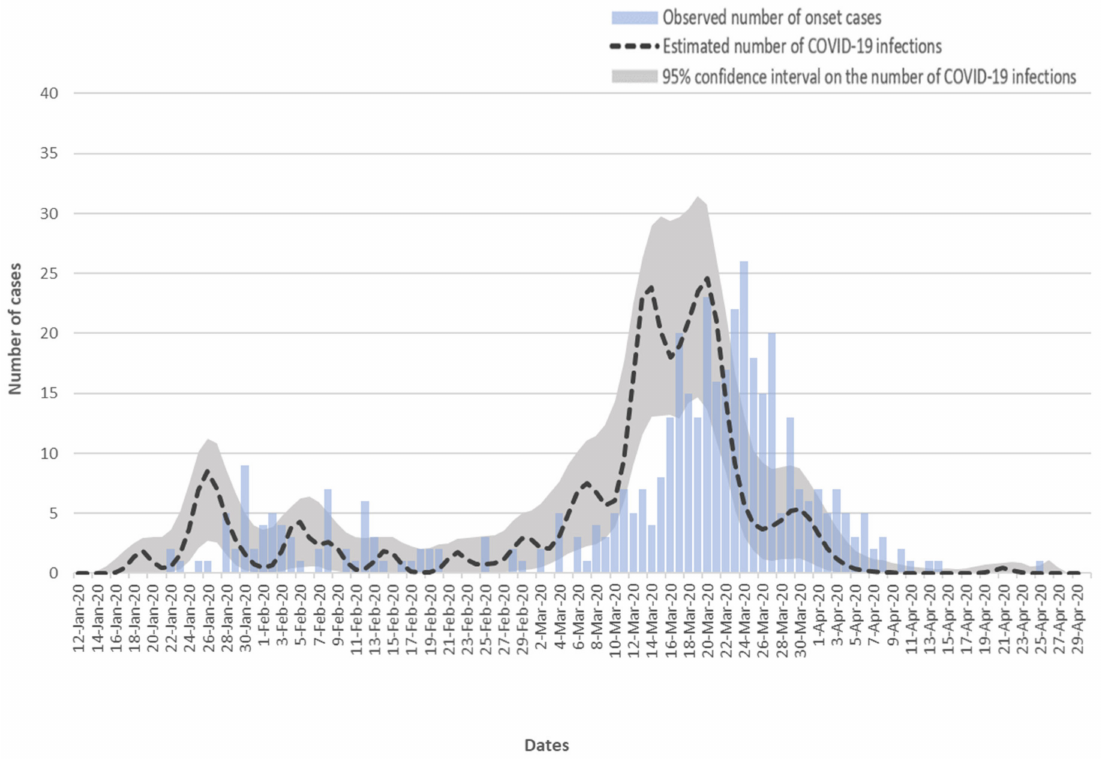
Figure 2. Estimated daily number of infections of the coronavirus disease (COVID-19) with pointwise 95% confidence intervals and the observed daily number of onset cases in Hong Kong from 12 January to 30 April